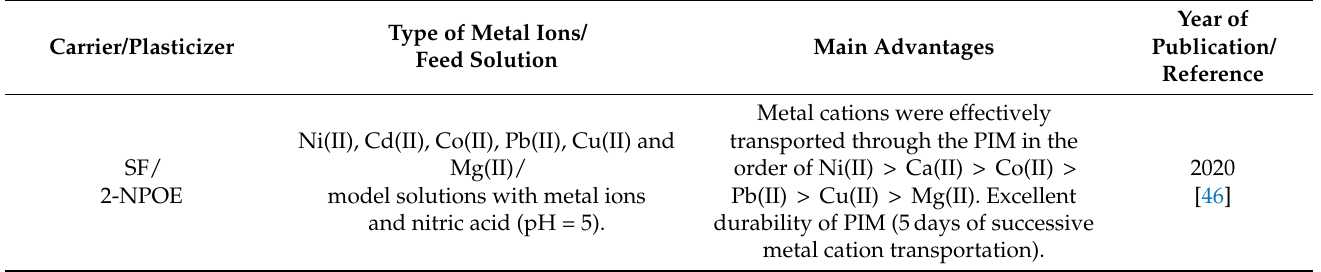
Table 2. Examples of PIMs prepared using CTA as base polymer and their applications for re- moval/transport of various metal